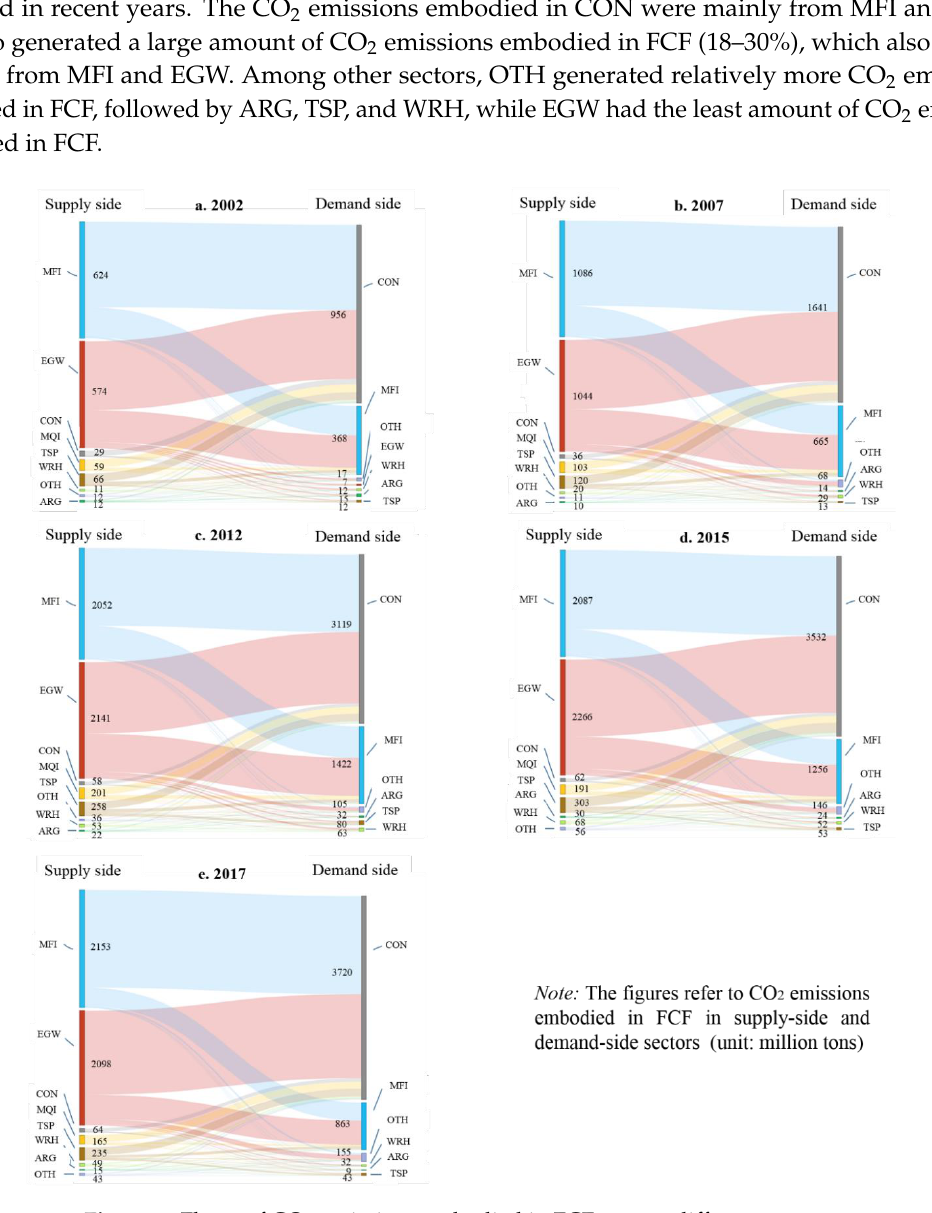
Figure 3. Flows of CO 2 emissions embodied in FCF among different sectors.